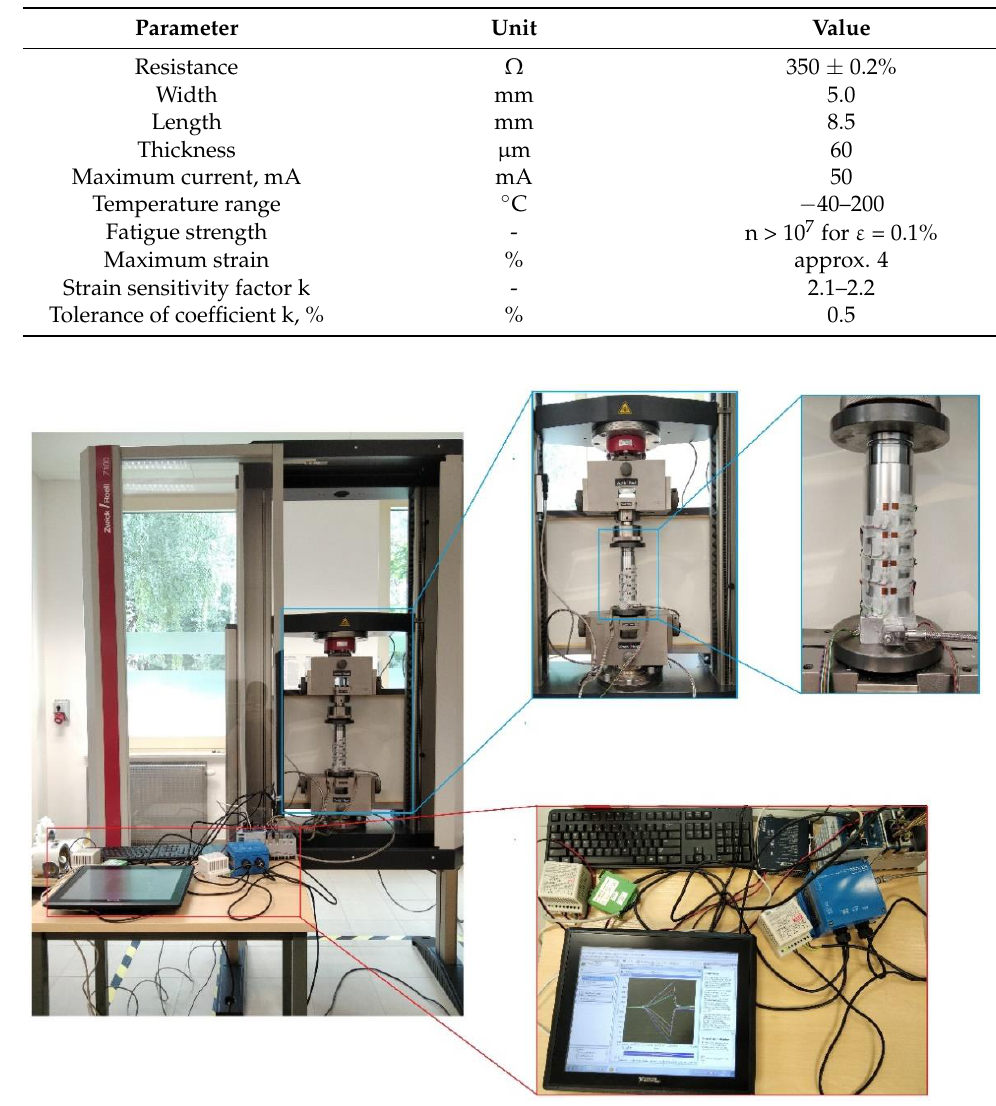
Figure 5. Strain measurement stand. Table 2. Parameters of the TF-5/350 strain gauge.